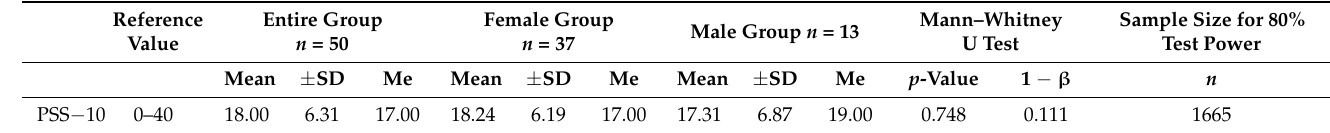
Table 2. Perceived Stress Scale with respect to the PSS − 10 in the study group ( n = 50) and for the group of females ( n = 37) and males ( n = 13). Mean standard deviation ( ± SD) and median (Me) are